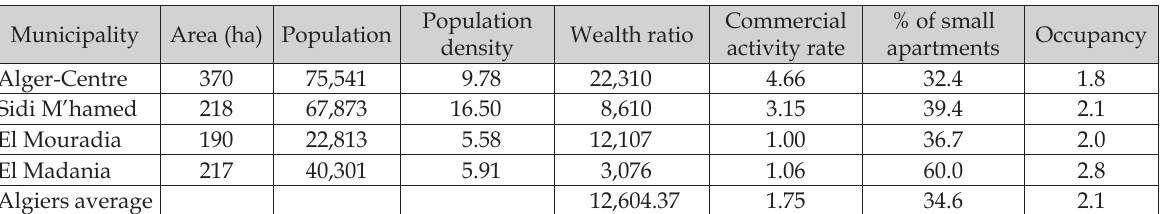
Table 2. Economic and social indicators comparing El Madania to other Sidi M’Hamed municipalities. Municipality Area (ha) Population